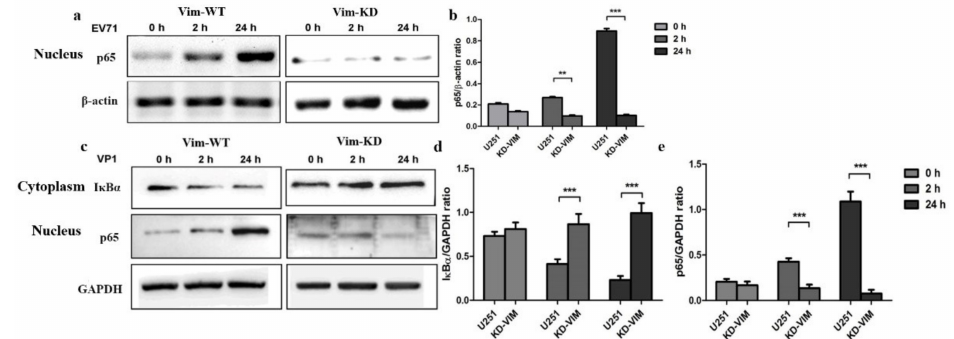
Figure 4. Role of vimentin in EV71 (VP1)-induced NF- κ B activation. ( a , b ) Role of vimentin in EV71- induced NF- κ B activation in nucleus. The levels of NF- κ B (p65) translocation to the nucleus were examined in nuclear fractions at zero hours, two hours and twenty-four hours. ( a ) The levels of NF- κ B (P65) were detected by Western immunoblotting. ( b ) NF- κ B (P65) and β -actin ratio analyzed by gray analysis of Western immunoblotting. ( c – e ) Role of vimentin in VP1-induced NF- κ B activation. ( c ) The levels of IKB α and NF- κ B (P65) detected by Western immunoblotting analysis, respectively. ( d , e ) IKB α or NF- κ B (P65) and GAPDH ratio analyzed by gray analysis of Western immunoblotting, respectively. ** p < 0.01, *** p <